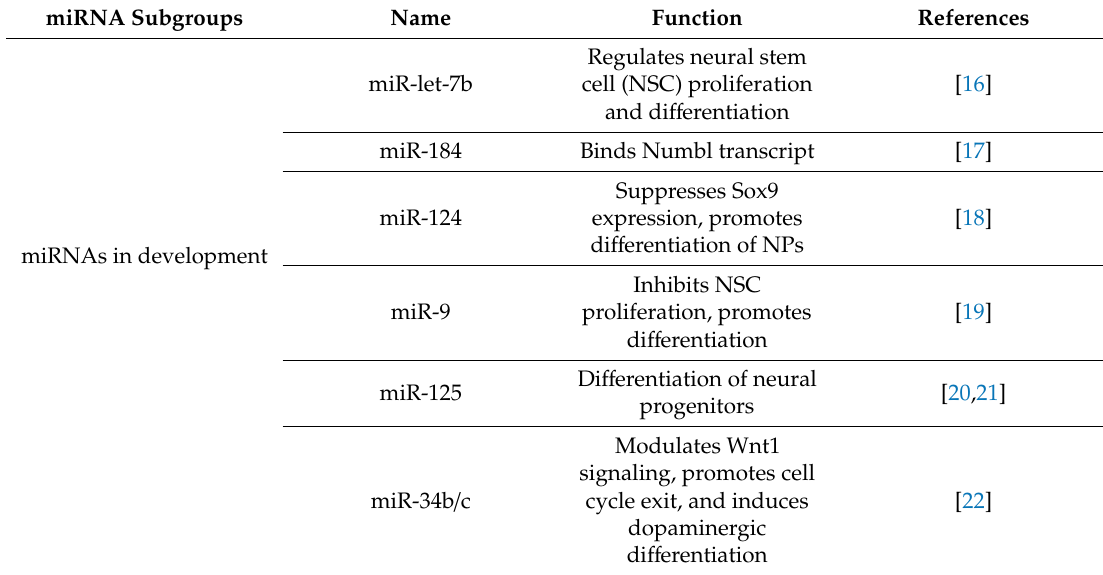
Table 1. Summary of microRNAs (miRNAs) involved in dopamine (DA) signaling